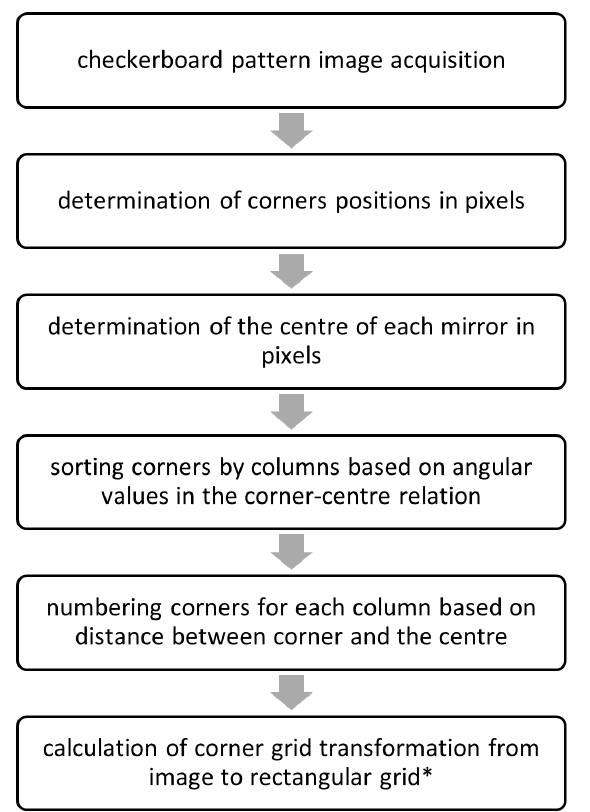
Figure 3. The scheme of the calibration procedure. * At this stage, output resolution is defined, and there is no need to change the resolution at other